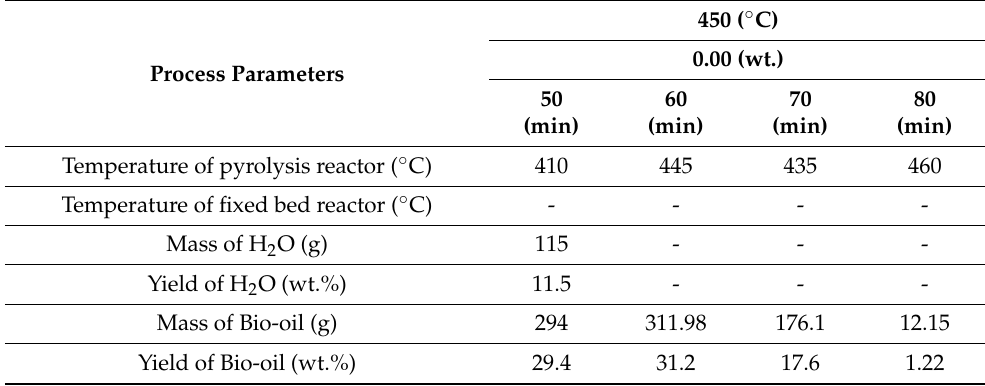
Table 4. Process parameters, mass balances, and partial yields of bio-oil and H 2 O during the course of reaction (50–80 min) of experiment conducted without catalyst.